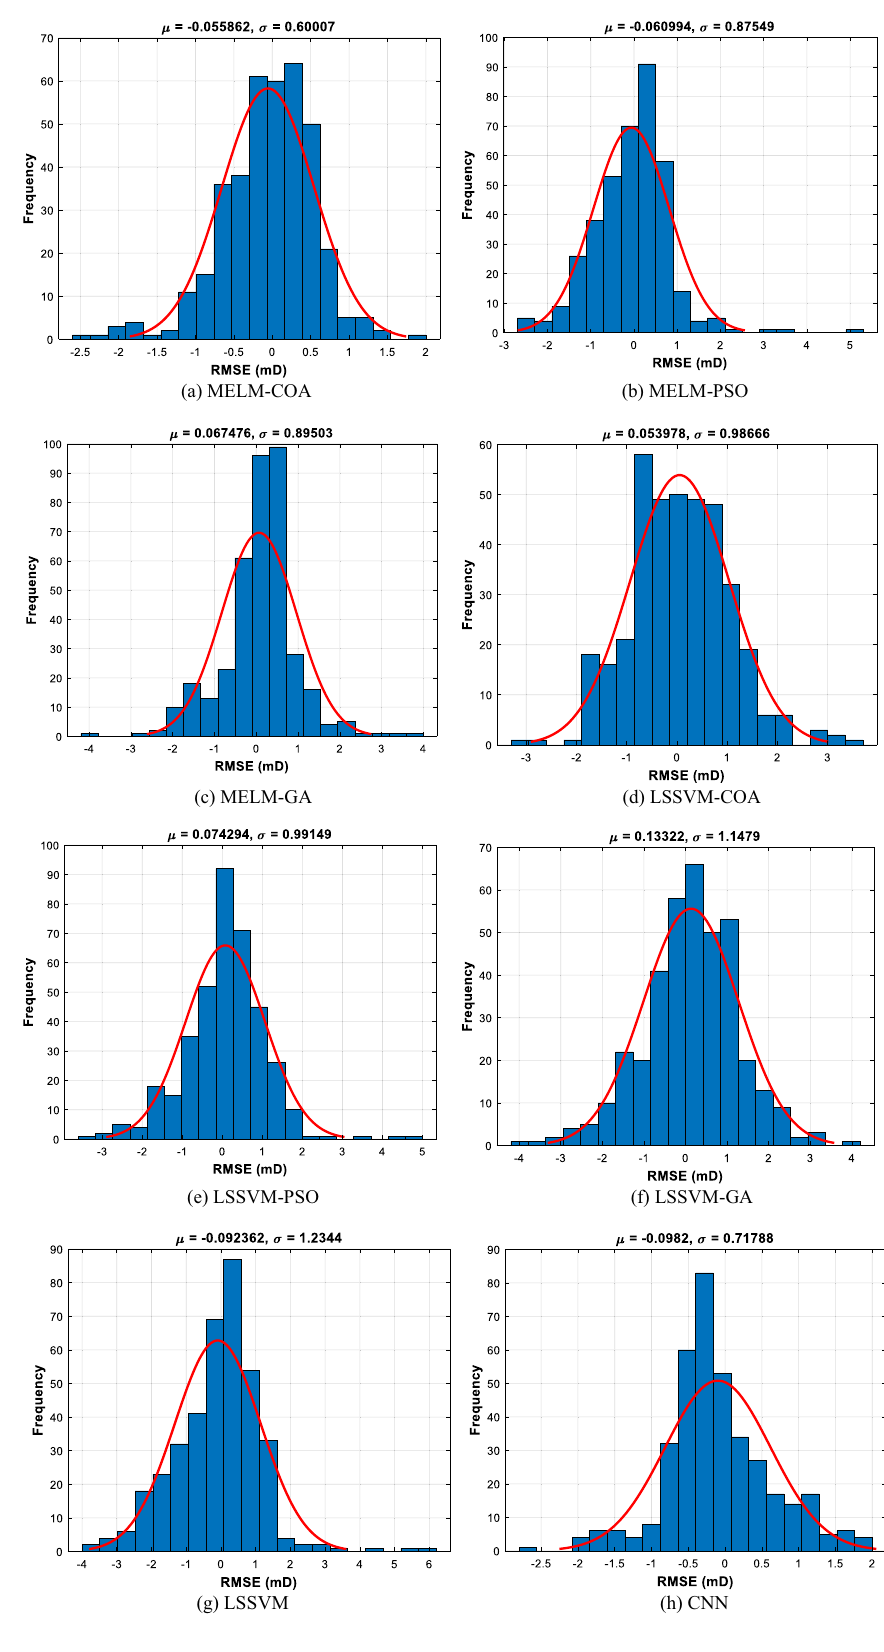
Fig. 12 Histogram of perme- ability modeling error for the testing data along with best-fit normal distribution function (red line). a MELM-COA